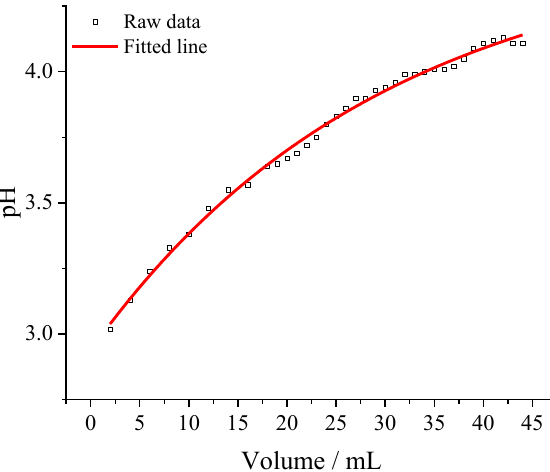
Figure 10. Plot of raw data and fitted line of pH values with dependence of the volume of 5 % NaOH droplets added into the mixture solutions of 0.02 M K 2 ZrF 6 and 0.02 M Cr(NO 3 ) 3 and the fitted line was functioned as “pH = − 1.56 × exp( −volume/29.7) + 4.49”. Figure 11 displayed Raman spectra of SurTec and Cr/Zr solution deposits when the bulk solution pH value was more than pH 7. The presence of chromium-, zirconium- 1060 (990) cm − 1 , respectively. In this sense, the pH-driven solution deposits from the SurTec 650 ChromitAL and in-house Cr/Zr solutions had comparable chemistry.